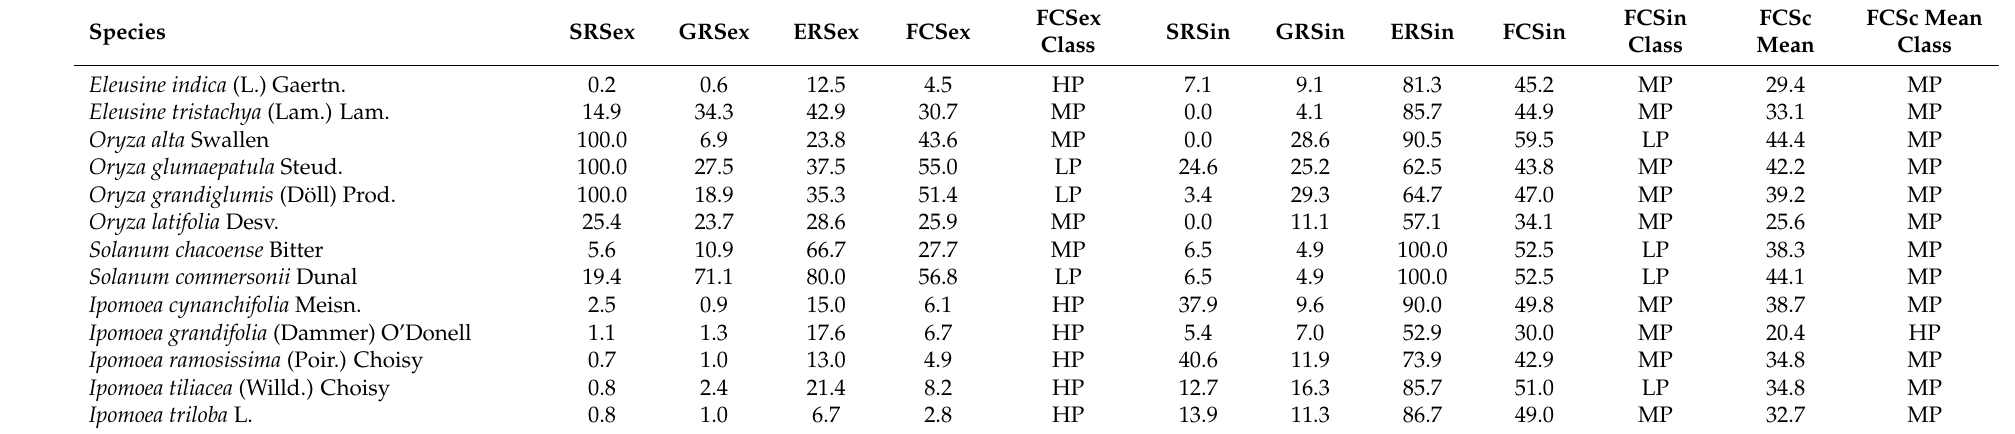
Table 2. Conservation gap analysis scores per taxon. sampling representativeness score ex situ = SRSex; geographical representativeness score ex situ = GRSex; ecological